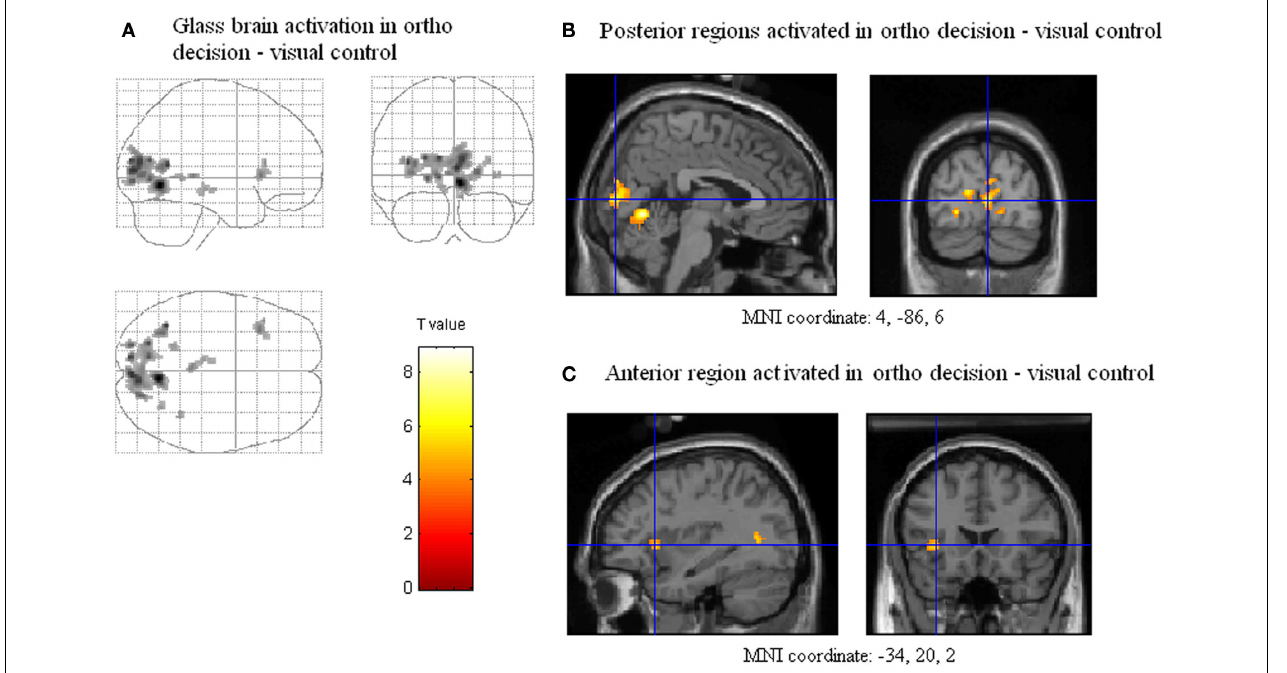
Table 2 |Activated regions in the auditory lexical decision compared to auditory control task. Region Z -score voxel Maximum peak coordinate (MNI)